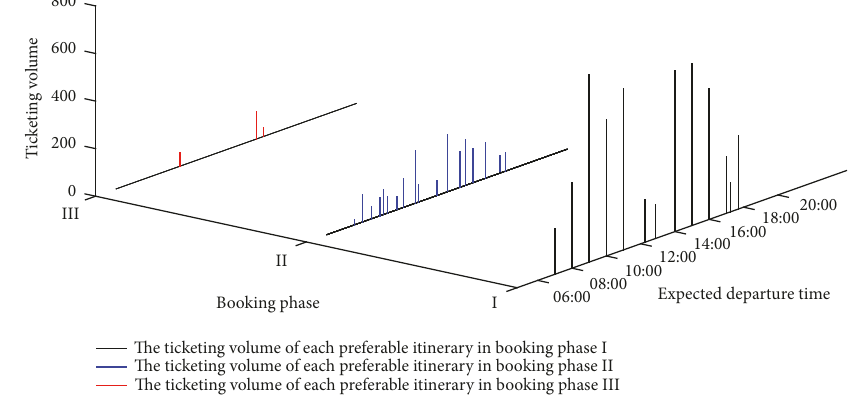
Figure 5: The ticketing volume of each itinerary in each booking phase from the SBPRA algorithm.